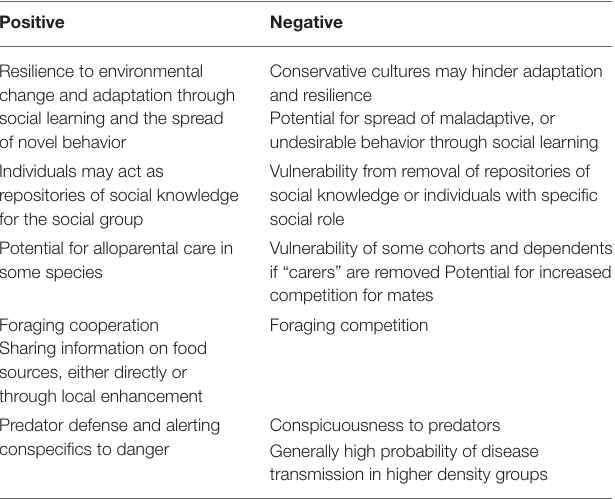
TABLE 2 | Summary of the importance of social living for wild animal welfare [after Brakes (11)]. Positive